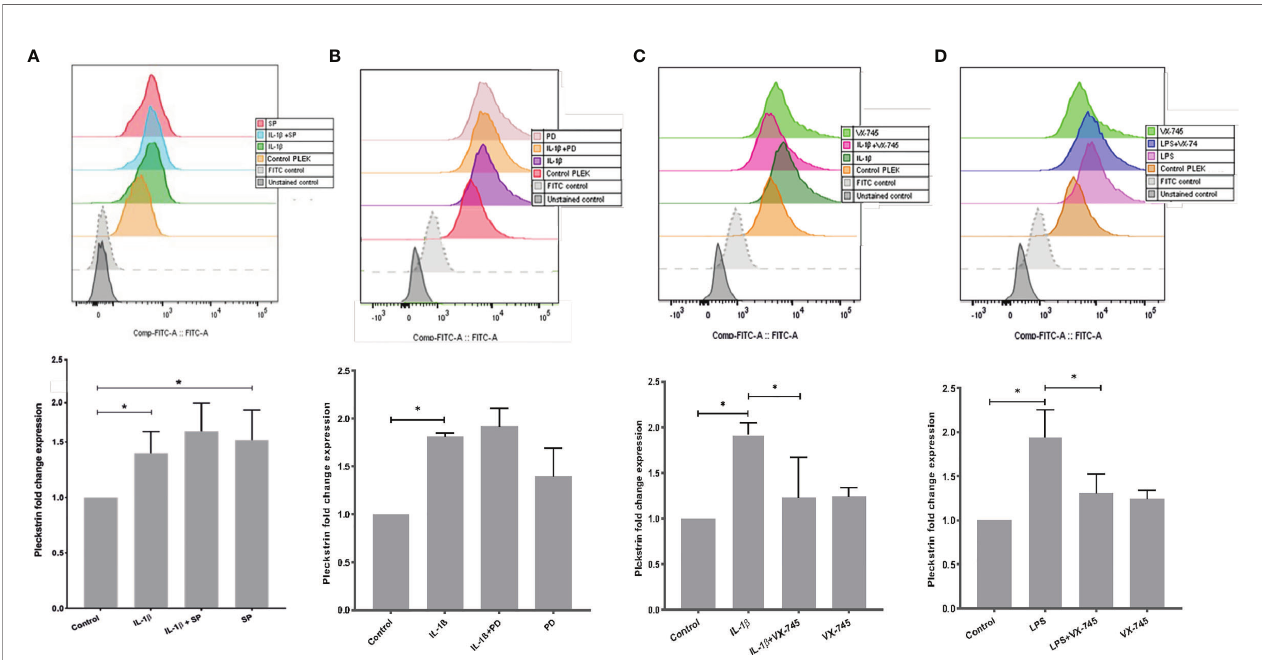
FIGURE 4 | Intracellular pleckstrin detection in HGFs analyzed by Flow cytometry. (A) Overlay histogram pro fi le and corresponding bar graph plot (shown below) showing intracellular pleckstrin fold change expression in response to IL-1 b treatment alone or in combination with SP in gingival fi broblasts. (B) Overlay histogram pro fi le and corresponding bar graph plot (below) showing intracellular pleckstrin fold change expression after IL-1 b treatment alone or in combination with PD in gingival fi broblasts. (C) Overlay histogram pro fi le and corresponding bar graph plot (below) showing intracellular pleckstrin fold change expression after IL-1 b treatment alone or in combination with VX-745 in gingival fi broblasts. (D) Overlay histogram pro fi le and corresponding bar graph plot (below) showing intracellular pleckstrin fold change expression after LPS treatment in the absence or presence of VX-745 in gingival fi broblasts. Data are presented as the mean values ± SD from at least three independent experiments. Signi fi cance was calculated with one-way ANOVA with Tukey ’ s multiple comparisons test where p-values were set as *p ≤ 0.05. SP SP600125 (inhibitor of c-Jun N-terminal kinase JNK); PD, PD 153035 hydrochloride (inhibitor of the epidermal growth factor receptor tyrosine kinase EGFR); VX-745, Ne fl amapimod (selective inhibitor p38 a MAPK inhibitor). Raw data images and gating strategies can be found in Supplementary Figure 3